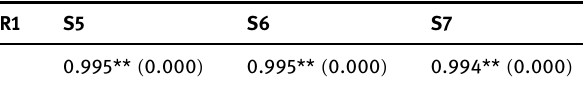
Table 3: Spearman ’ s correlation coe ffi cients and p values for 1 cm thick bolus samples comparisons ( p values in parenthesis )